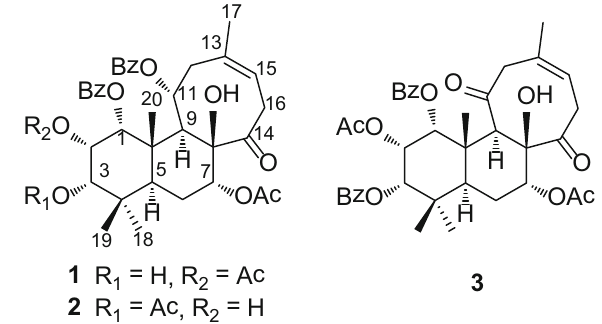
Fig. 1 The structures of compounds 1 –